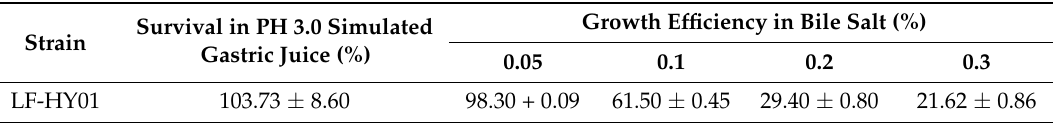
Table 1. Effect of simulated gastric juice and bile salt on viability of